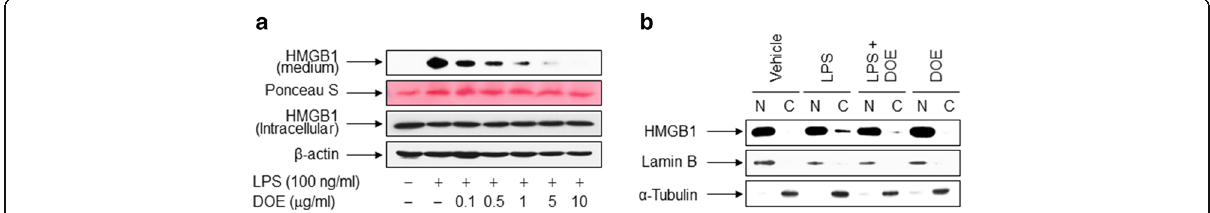
Fig. 2 DOE inhibits LPS-triggered release of HMGB1 in RAW 264.7 cells. a Cells cultured for 24 h in serum-free medium were triggered by vehicle (DMSO) or LPS in the presence or absence of DOE. Following incubation for 24 h, aliquots of conditioned media or whole-cell lysates were analyzed by immunoblot analysis. Ponceau S staining and β -actin were used as the loading controls. b Cells were treated with vehicle (DMSO) or LPS in the presence or absence of DOE for 24 h, and then whole-cell lysates were fractionated into cytosolic (C) and nuclear (N) fractions. The localization of HMGB1 was analyzed by immunoblotting with the indicated antibodies. Representative blots from three independent experiments are